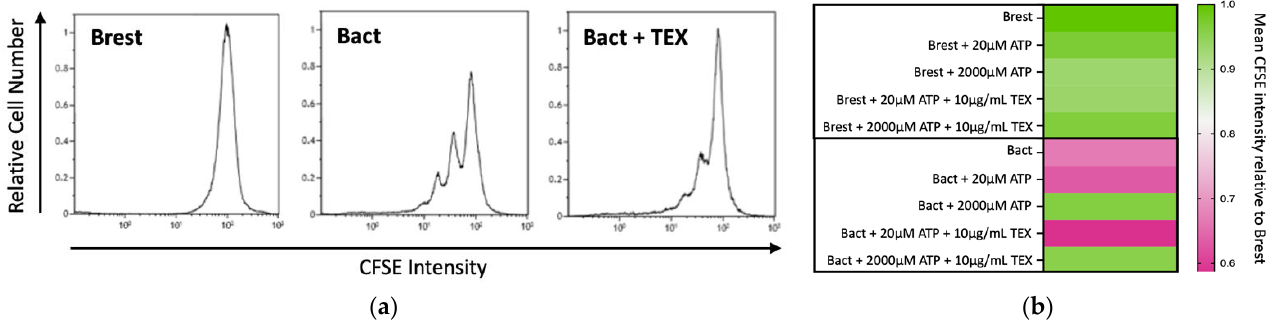
Figure 2. ( a ) Representative flow cytometry (CFSE assay) of resting B cells (Brest), activated B cells (Bact), and activated B cells co-incubated with 10 µg/mL of tumor-derived exosomes (TEX). ( b ) Heatmap with a relative proliferation index compared to Brest (value = 1) in a flow-cytometry-based CFSE assay. Lower values mean less CFSE fluorescence compared to Brest and, as such, proliferation of cells. The mean of four independent experiments is shown on the heatmap.